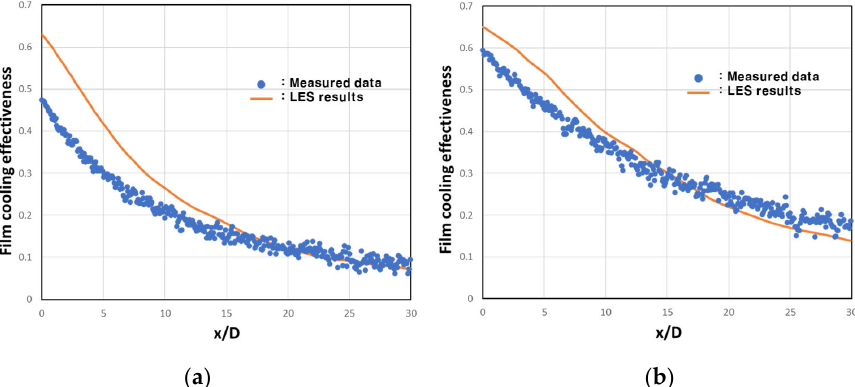
Figure 13. Film cooling effectiveness distributions along the centerline at ( a ) BR = 1.0 and ( b ) BR = 2.0.